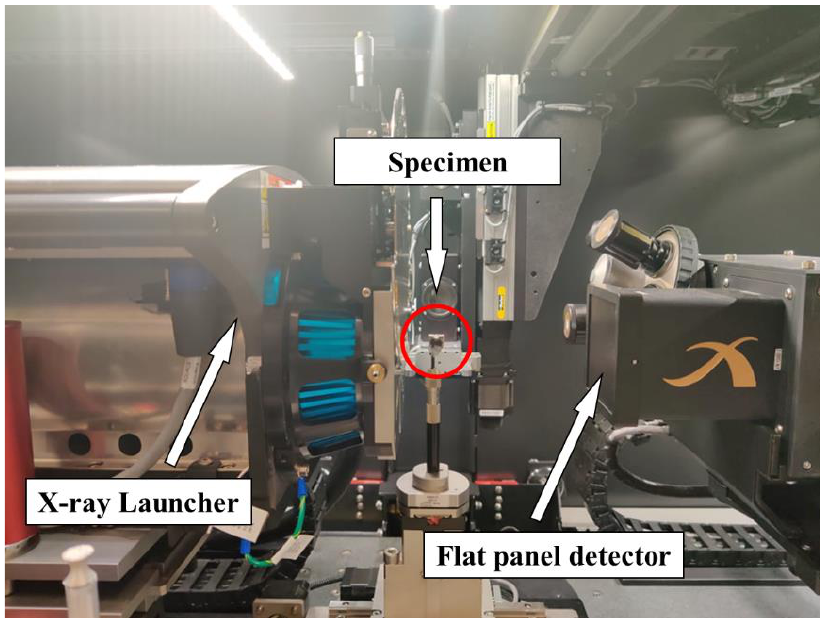
Figure 1. CT Scanning set-up for norite after thermal treatment.